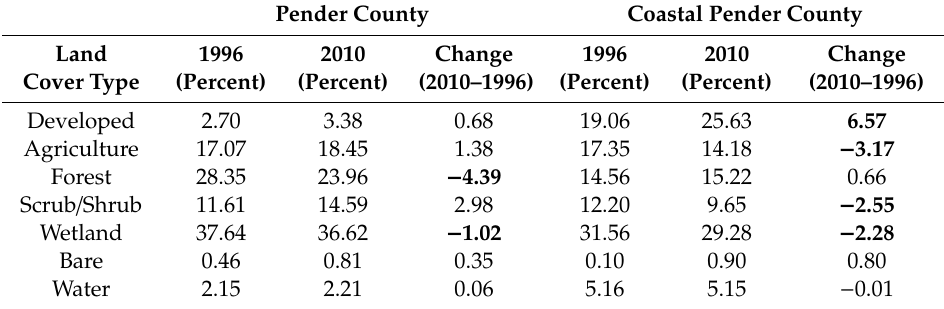
Table 5. Land Cover Change Matrix (in percent): 1996 – 2010. (Data source: C-CAP).